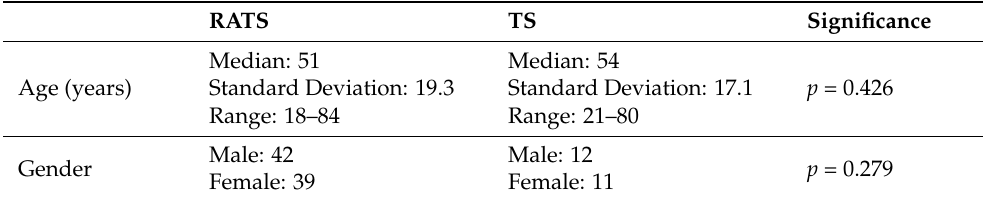
Table 1. Patient